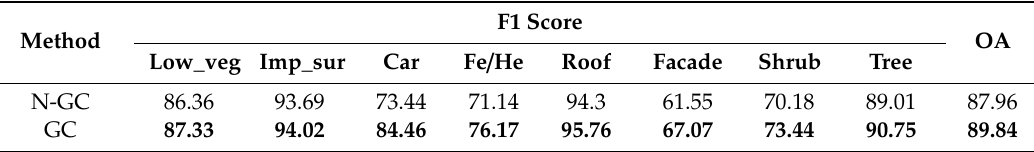
Table 2. F1 score of each class and overall accuracy (OA) with and without graph-cuts optimization on ISPRS benchmark dataset. Bold numbers show the highest values